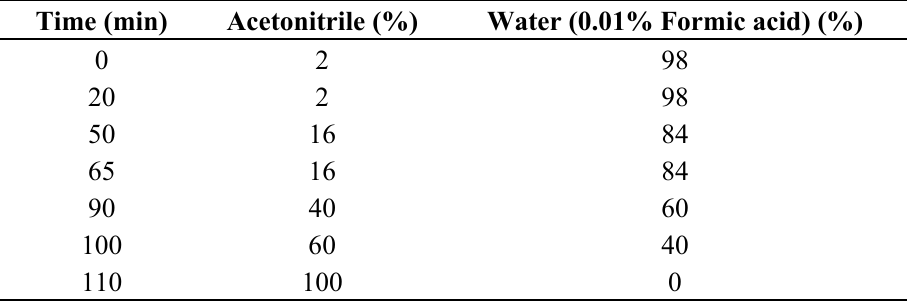
Table 1. Gradient elution